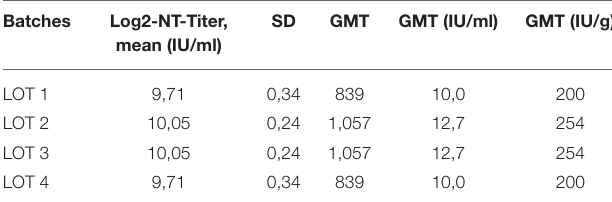
TABLE 2 | Investigation on MV-neutralizing antibody capacity tested from samples from four different batches.